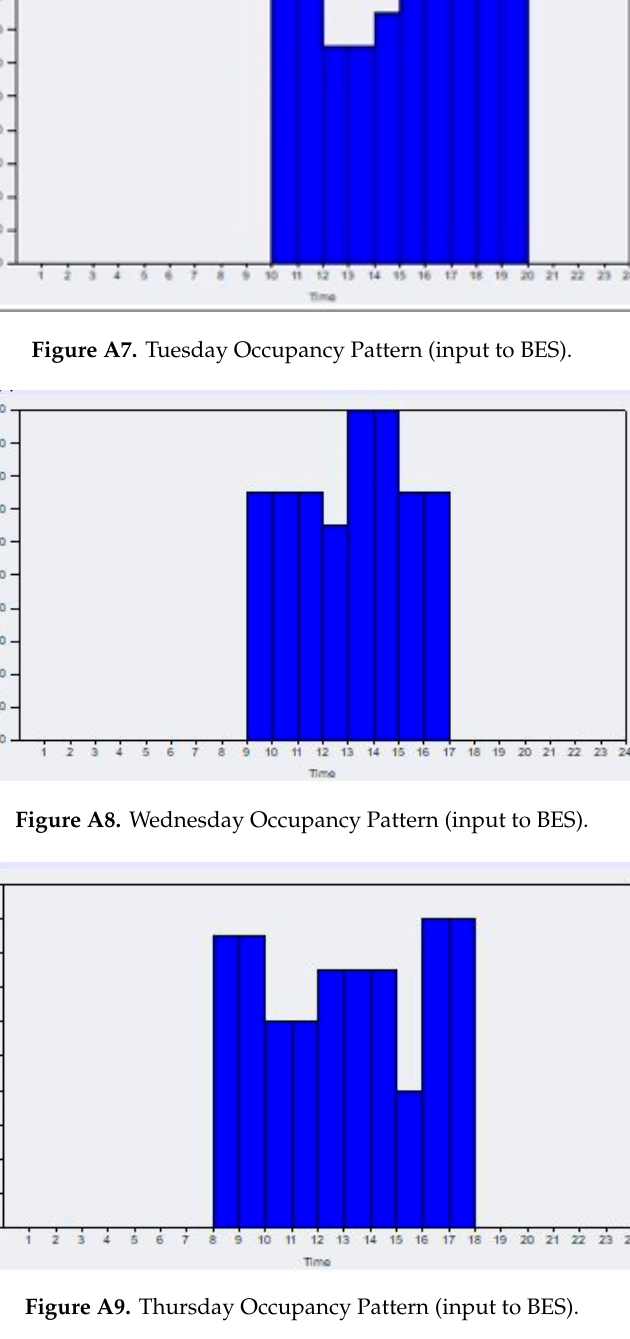
Figure A9. Thursday Occupancy Pattern (input to BES).